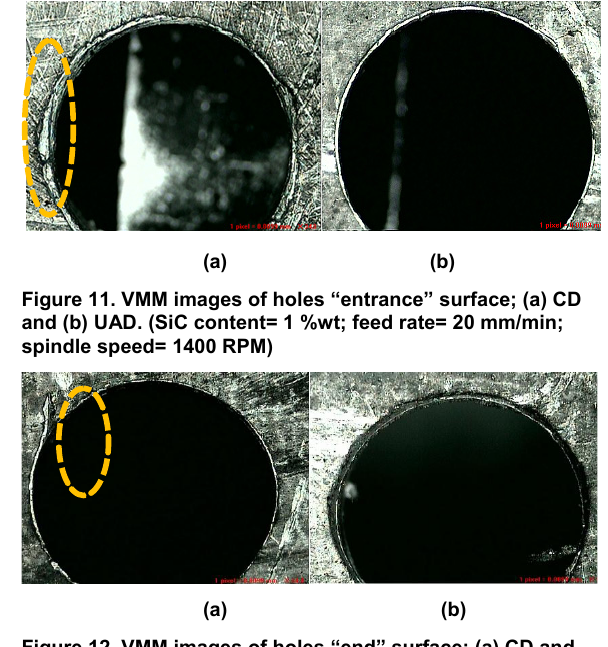
Figure 12. VMM images of holes “end” surface; (a) CD and (b) UAD. (SiC content= 1 %wt; feed rate= 20 mm/min; spindle speed= 1400